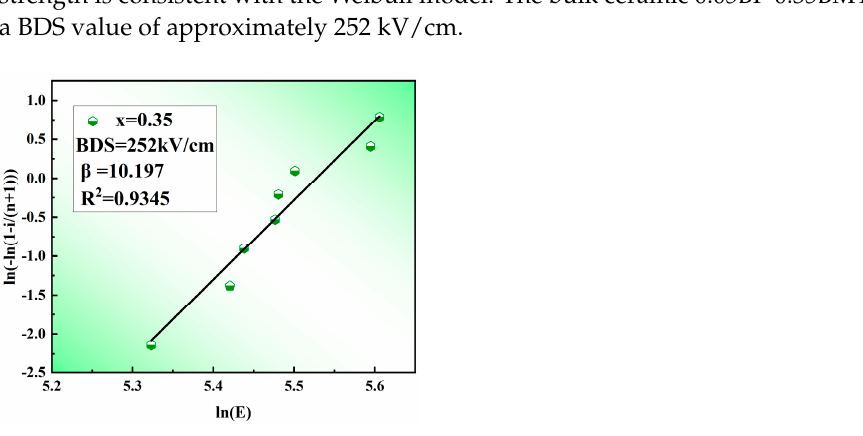
Figure 4. Weibull distribution of the BDS of 0.05BF-0.35BMT-0.6BT ceramics.